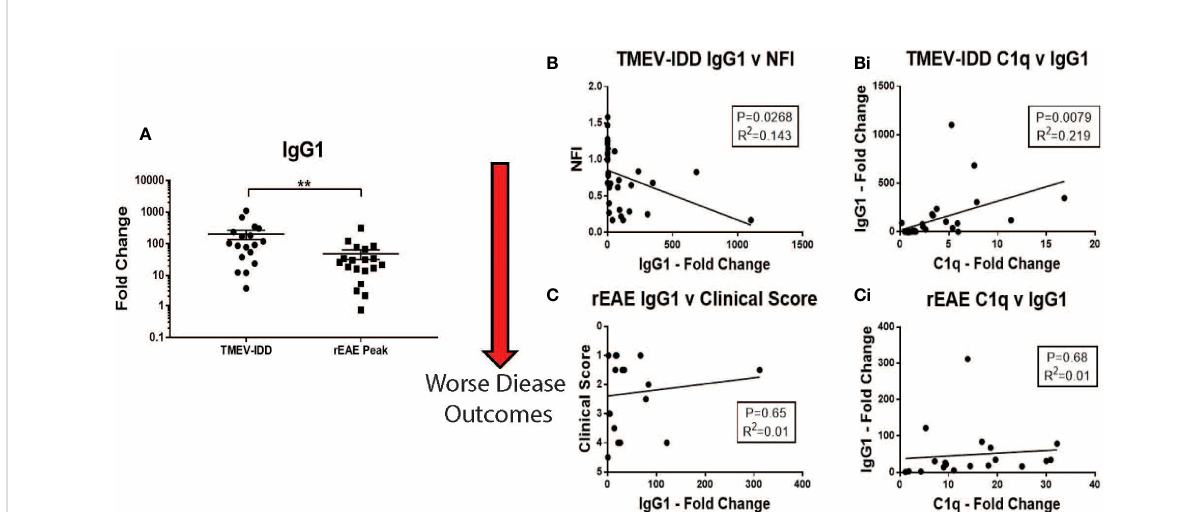
FIGURE 6 Correlations between IgG1, C1q and disease outcomes in TMEV-IDD and rEAE. Gene expression of IgG1 and C1q was determined by rt-PCR in spinal cords from TMEV-IDD mice (n = 26) at day ~120 post-infection or rEAE mice (n = 20) at day ~15 post-immunization. (A) The scatter plot displays IgG1 expression in TMEV-IDD vs. rEAE mice with mean ± SEM for the group. Fold changes were calculated between diseased and age- matched sham mice. Signi fi cant differences are indicated by **(P < 0.01) as determined by Mann-Whitney U-test. (B, Bi) Linear regression analysis shows that during TMEV-IDD, high IgG CNS expression correlates with (B) a worse disease outcome and (Bi) higher levels of C1q. In contrast, (C, Ci) during rEAE IgG1 CNS expression does not correlate with the clinical outcome or C1q levels. P value and the coef fi cient of determination R2 are indicated in each